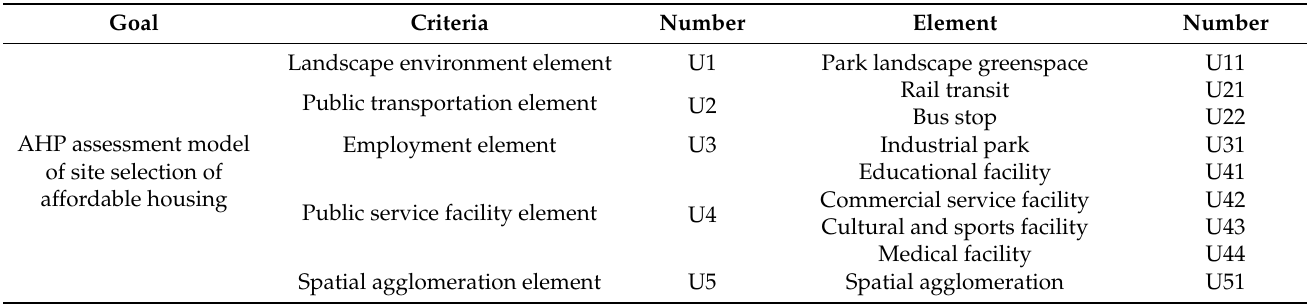
Table 6. The analytic hierarchy process model of site selection.